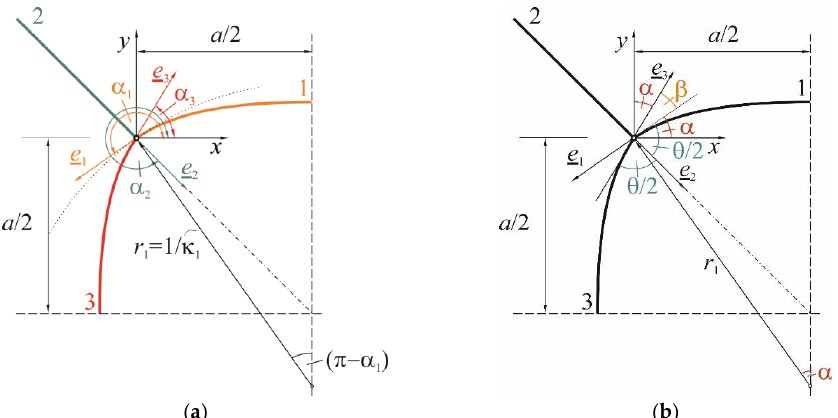
Figure 2. Sketch of the situation at the triple point: ( a ) The directions of the grain boundaries 1, 2, and 3 at the triple point are given by the unit vectors e 1 , e 2 , and e 3 , which comprise the angles α 1 , α 2 and α 3 with the x -axis. ( b ) The directions of the grain boundaries 1, 2, and 3 at the triple point are determined by the dihedral angle θ , the turning angle β and the angle α enclosed by grain boundary 1 at the triple point and the x